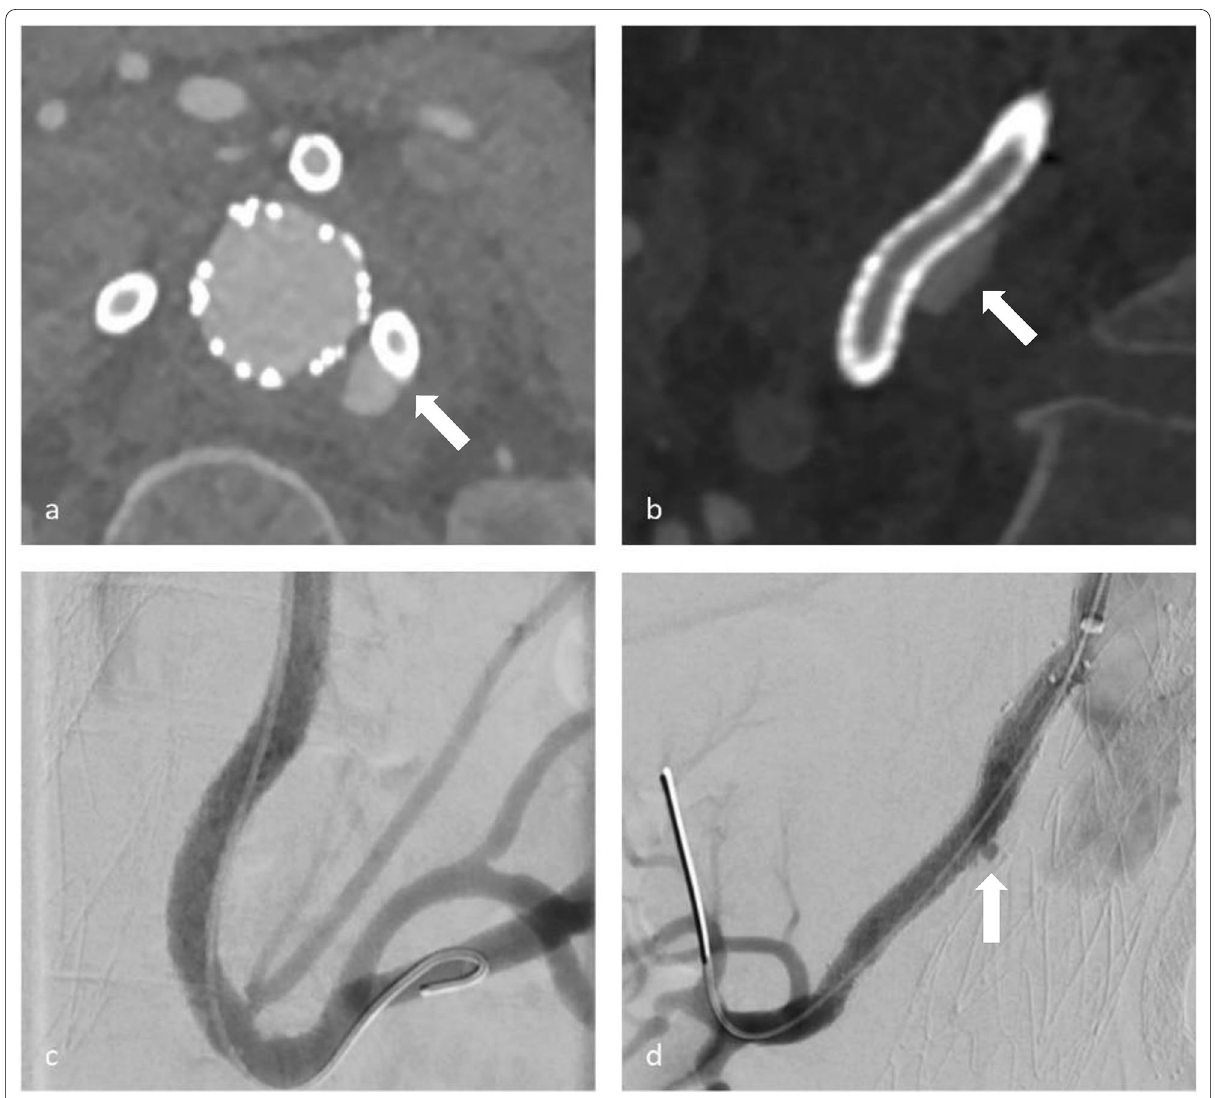
Fig. 7 Endoleak adjacent to the left renal BSG in CTA ( a , b ). While the endoleak could not be confirmed in angiography ( c ), a previously undetected endoleak of the right renal BSG was found ( d ). Both BSGs were successfully religned. BSG CTA computed tomography =